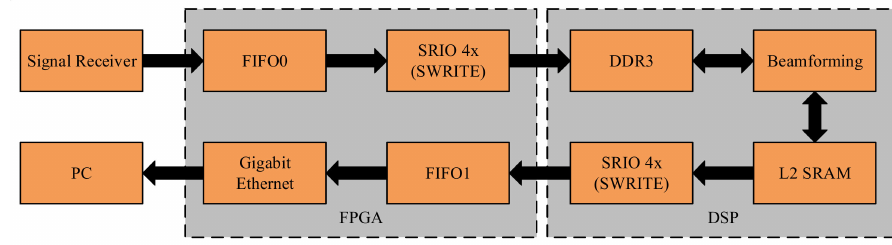
Figure 16. The transmission path of acquisition data.